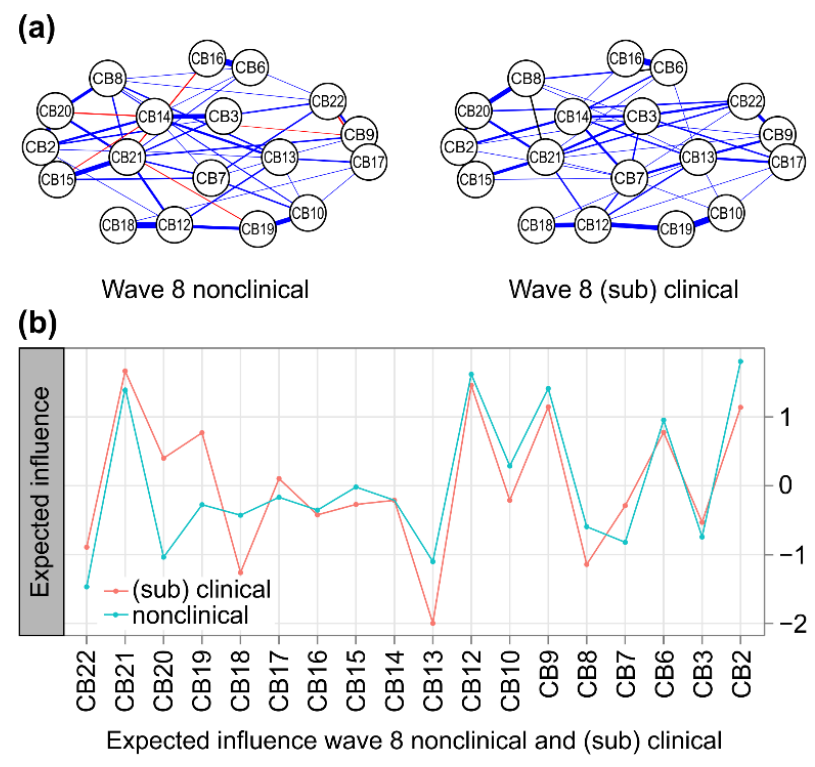
Figure 4. ( a ) Comparison of CBCL behavioral problems in nonclinical ( left ) and (sub)clinical ( right ) groups of 18 nodes. The blue lines present positive associations, and the red lines indicate negative ones. The width and brightness of the edge indicate the strength of the association. The maximum edge in the nonclinical group was 0.84 (CB6 = Attention problems; CB16 = Social Problems) and the maximum edge in the (sub)clinical group was 0.73 (CB6 = Attention problem; CB16 = Social Problems), but the maximum edge was unified as 0.55 for comparison. ( b ) Nonclinical (total problem behavior T-score < 60, blue) versus (sub)clinical (total problem behavior T-score ≥ 60, orange) individual node strength values are shown as standardized z-scores. CB1 = emotionally reactive; CB2 = anxious/depressed; CB3 = somatic complaints; CB4 = withdrawn; CB5 = sleep problems; CB6 = at- tention problems; CB7 = other problems; CB8 = other problems; CB9 = DSM affective problems; CB10 = DSM anxiety problems; CB11 = DSM pervasive developmental problems; CB12 = DSM attention- deficit/hyper-activity problems; CB13 = DSM oppositional defiant problems; CB14 = withdrawn/de- pressed; CB15 = rule-breaking behavior; CB16 = social problems; CB17 = thought problems; CB18 = DSM somatic problems; CB19 = DSM conduct problems; CB20 = obsessive–compulsive symptom; CB21 = posttraumatic stress problems; CB22 = sluggish cognitive tempo.